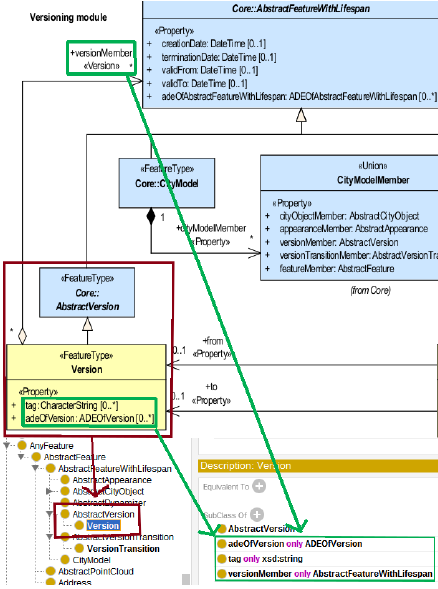
Figure 3. CityGML 3.0 vers:Version UML (top) to OWL Class (bottom)